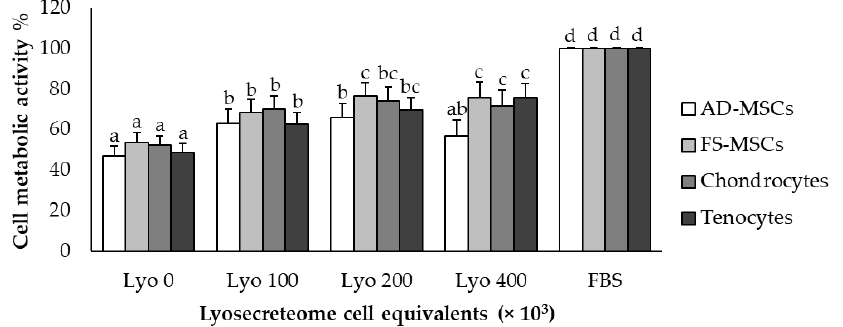
Figure 7. Cell metabolic activity on AD-MSCs, SF-MSCs, tenocytes, and chondrocytes tested at different Lyosecretome concentrations demonstrating a dose-dependency up to 200,000 cell equivalents/well. Mean values ± LSD ( n = 4), ANOVA. Different letters (a, b, c, d) indicate significant differences between the means ( p < 0.05), whereas the same letter indicates no significant difference ( p > 0.05). FBS indicates the positive control, while Lyo 0 stands for the negative